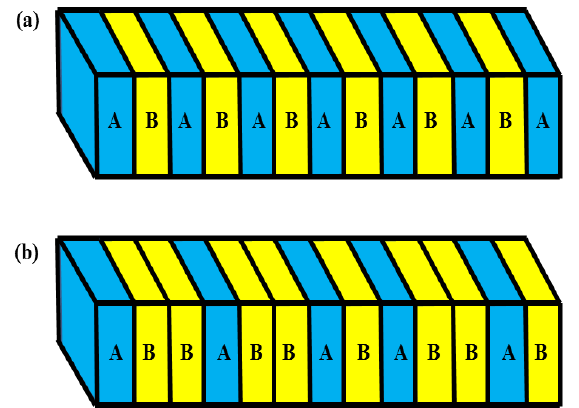
Figure 1: 1-Dimensional Conventional Photonic Crystal Structure (a) and Fibonacci Photonic Crystal Structure